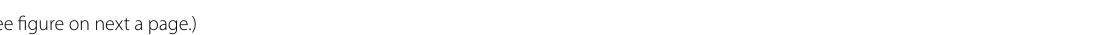
Fig. 8 Profiles of underground velocity structures between the surface and the bottom of boreholes (upper) and H / V s (lower) at six KiK‑net strong‑ motion stations. In the upper panels, thin black lines show the profiles of initial underground velocity structures, light pink lines show the profiles of underground velocity structures identified during all the iterations, and thick black lines show the profiles of identified underground velocity struc‑ tures. In the lower panels, thick black curves denote the observed H / V s, thin black curves denote the SW H / V s of initial cap‑layered media, light pink curves denote the SW H / V s of all identified cap‑layered media during the iterations, red curves denote the SW H / V s of identified cap‑layered media, and cyan curves denote the FW H / V s of identified layered media. The numerical values in black represent the objective function Em between observed H / V s and SW H / V s of initial cap‑layered media, and the numerical values in red represent the objective function Em between observed H / V s and SW H / V s of identified cap‑layered